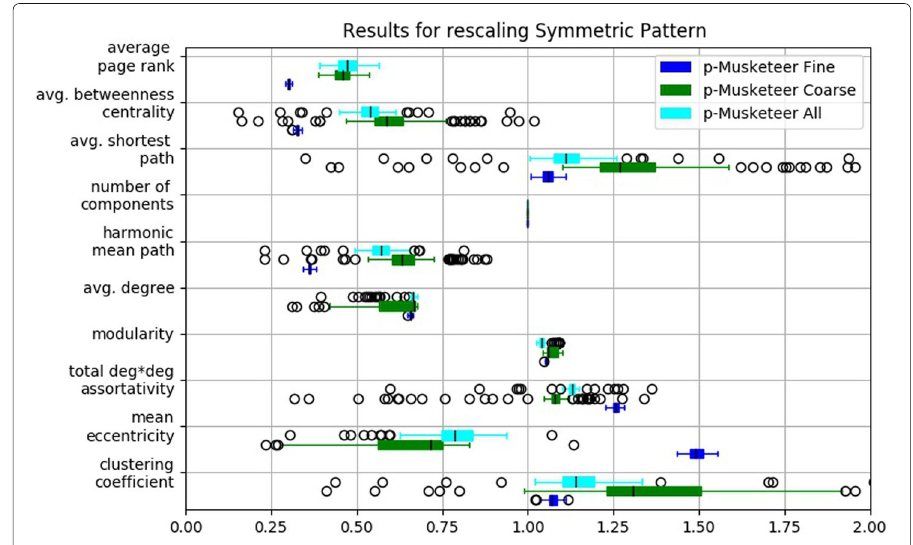
Fig. 21 Computational results on performance of planar Musketeer on symmetric pattern with 1141 nodes and 3162 edges to at least 2200 nodes and 6000 edges